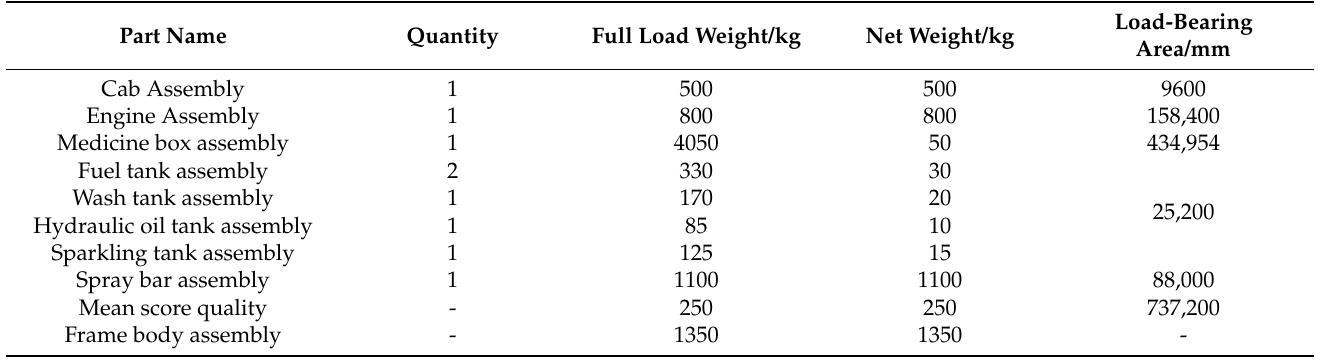
Table 3. Frame base load.